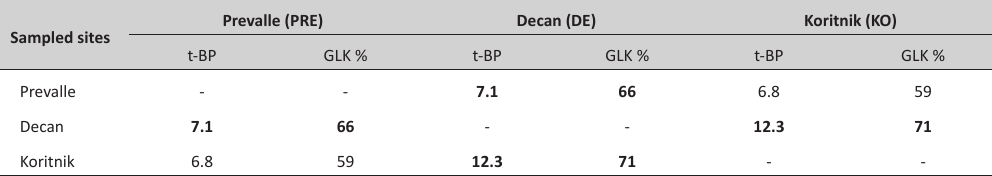
taBLe 3. Comparison between all three P. heldreichii chronologies from Kosovo sampled